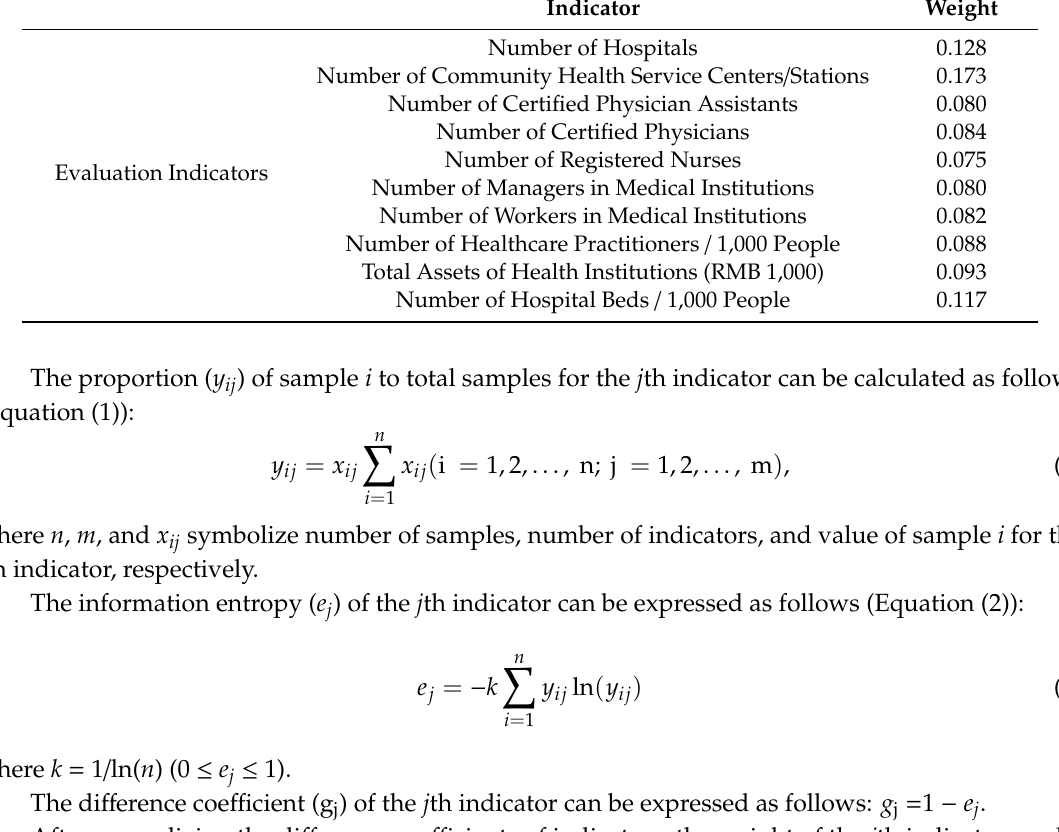
Table 1. Indicator system and weights for evaluation of health resource agglomeration capacities. Indicator Weight